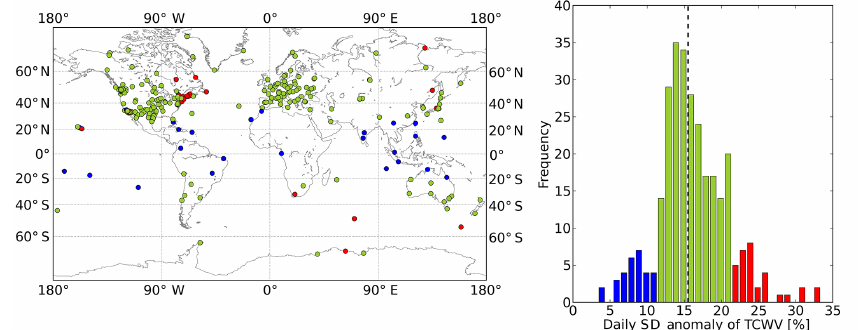
Figure 9. Mean daily standard deviation (DSD) anomaly from the daily mean TCWV in percentage. Right plot: histogram of the DSD, blue bars indicate the classes that are in the 10th percentile, red bars indicate classes that are above the 90th percentile; the vertical dashed line illustrates the position of the station-median standard deviation anomaly. Left plot: spatial distribution of stations coloured in the three percentile classes.